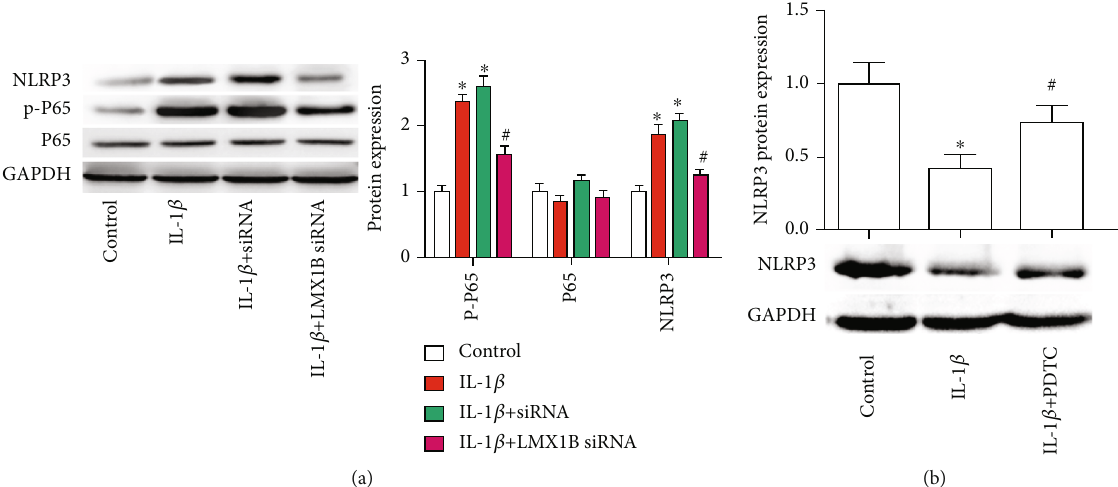
Figure 7: LMX1B depletion suppressed IL-1 β -induced NF- κ B and NLRP3 activation. Western blot was used to determine the protein expression of p-P65, P65 (a), and NLRP3 (b). SW1353 cells were transfected with control siRNA or LMX1B siRNA for 24h by using Lipofectamine 2000 reagent and then treated with 10 ng/ml IL-1 β for 24 h, or SW1353 cells were treated with 10 ng/ml IL-1 β and PDTC for 24h. ∗ P < 0 : 05 , compared with the control group; # P < 0 : 05 , compared with the IL-1 β group. All experiments were repeated three